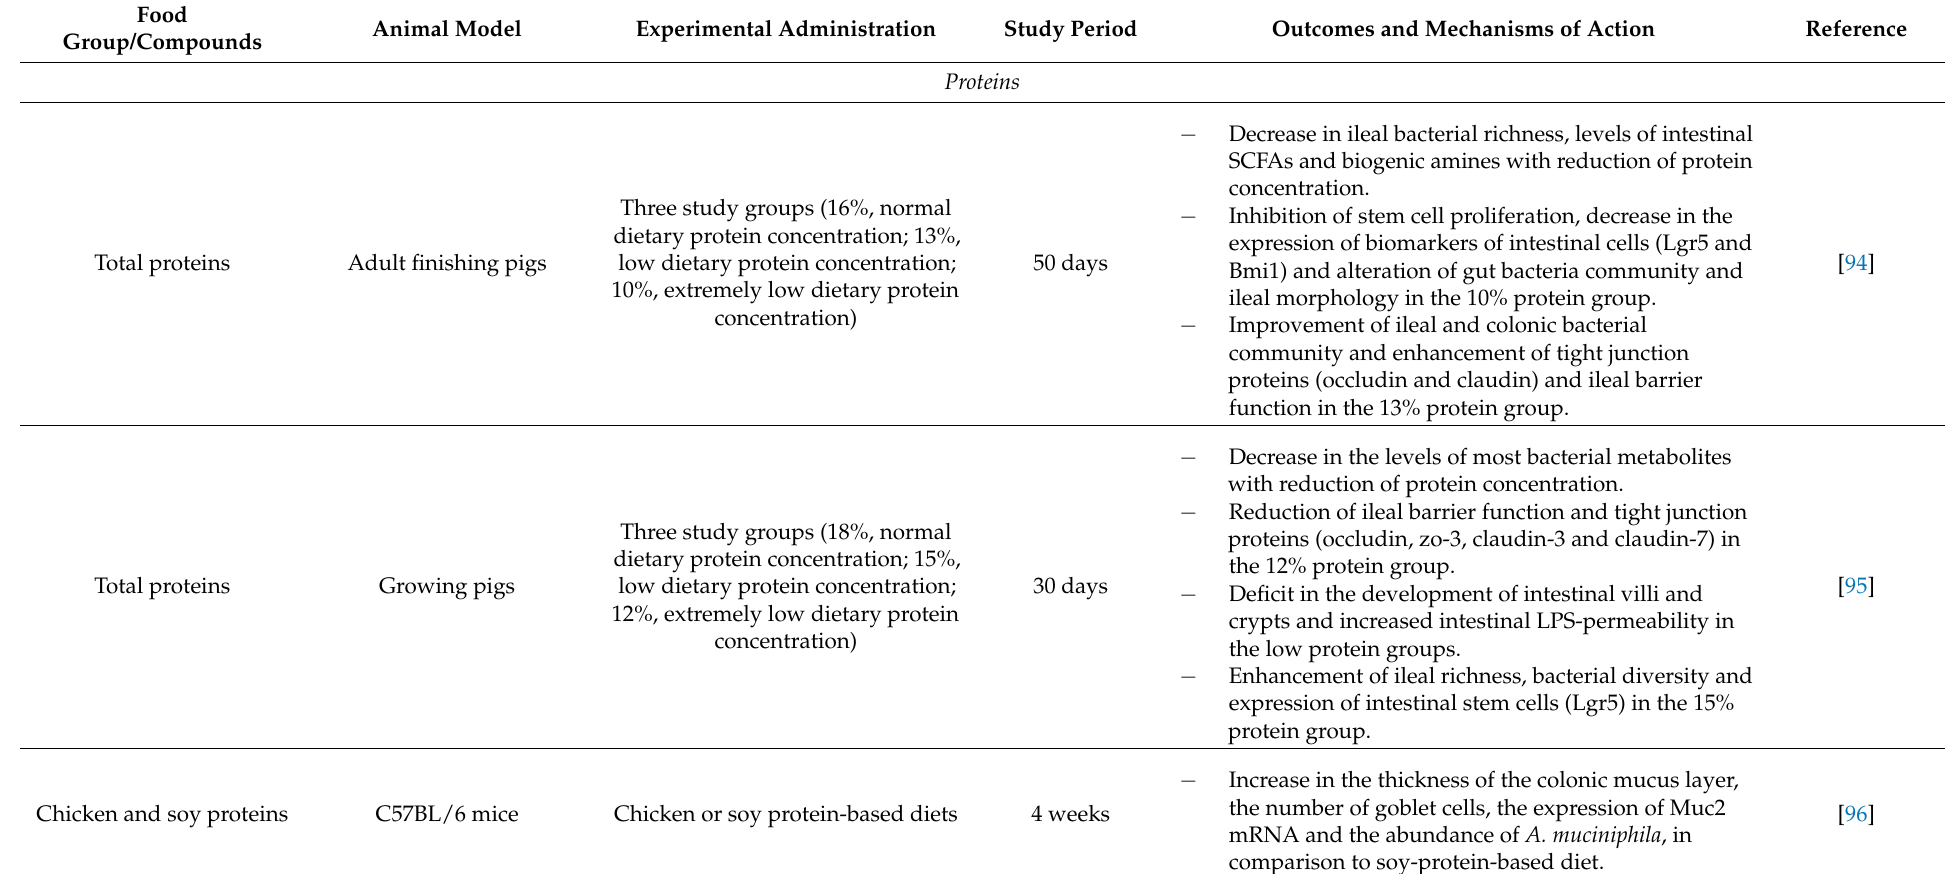
Table 2. Summary of studies evaluating in animal models the effects of food compounds on the mucus